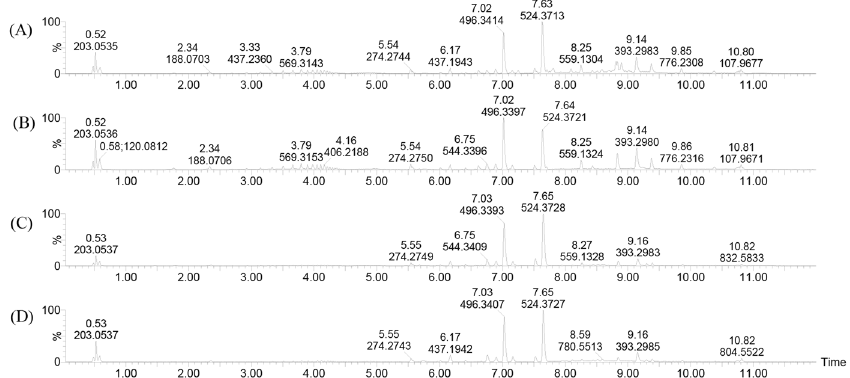
Figure 4. Positive ion base peak intensity (BPI) chromatogram of representative serum samples from ( A ) resistant and ( B ) susceptible groups sampled on day 21, and ( C ) resistant and ( D ) susceptible groups sampled on day 35.